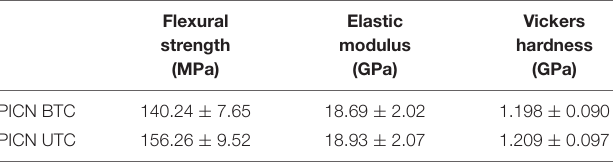
TABLE 2 | Mechanical properties of two polymer-infiltrated ceramic network composites (PICNs). Flexural